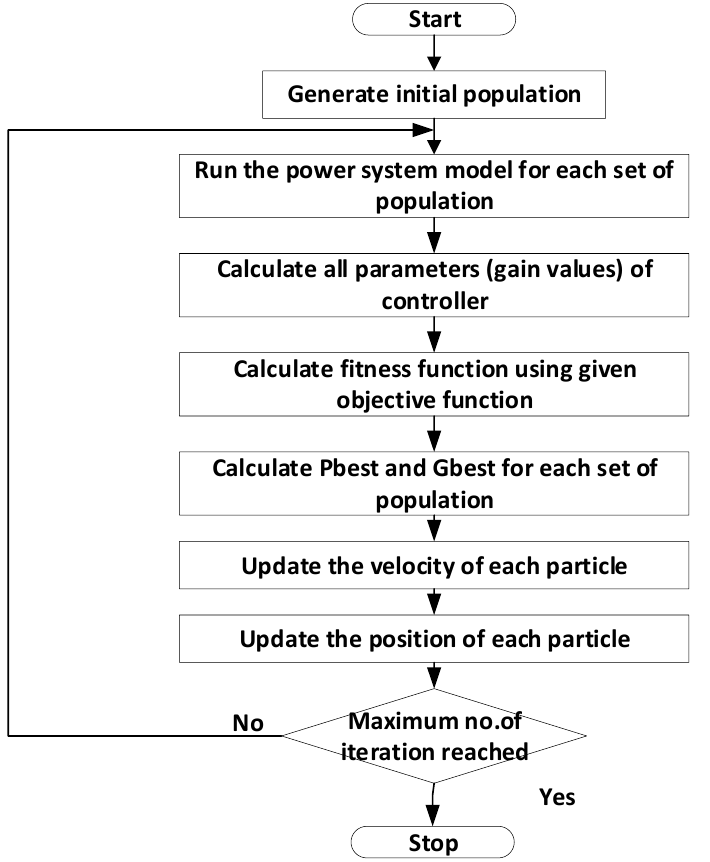
Figure 6. Flow chart of the PSO for PID controller tuning.